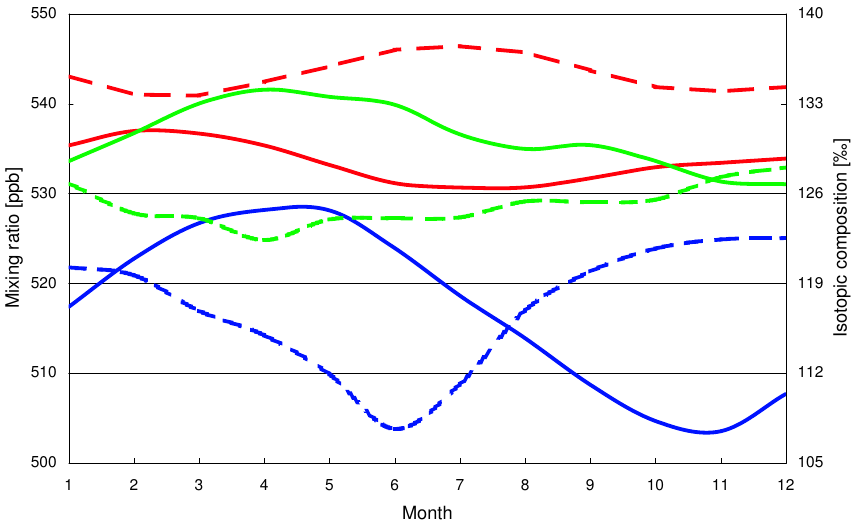
Fig. 7. The modelled seasonal cycle of the H 2 mixing ratio (full lines) and isotopic composition (dashed lines) derived from the budgets of the latitude bands from (blue) 90 ◦ N to 30 ◦ N, (green) 30 ◦ N to 30 ◦ S, and (red) 30 ◦ S to 90 ◦